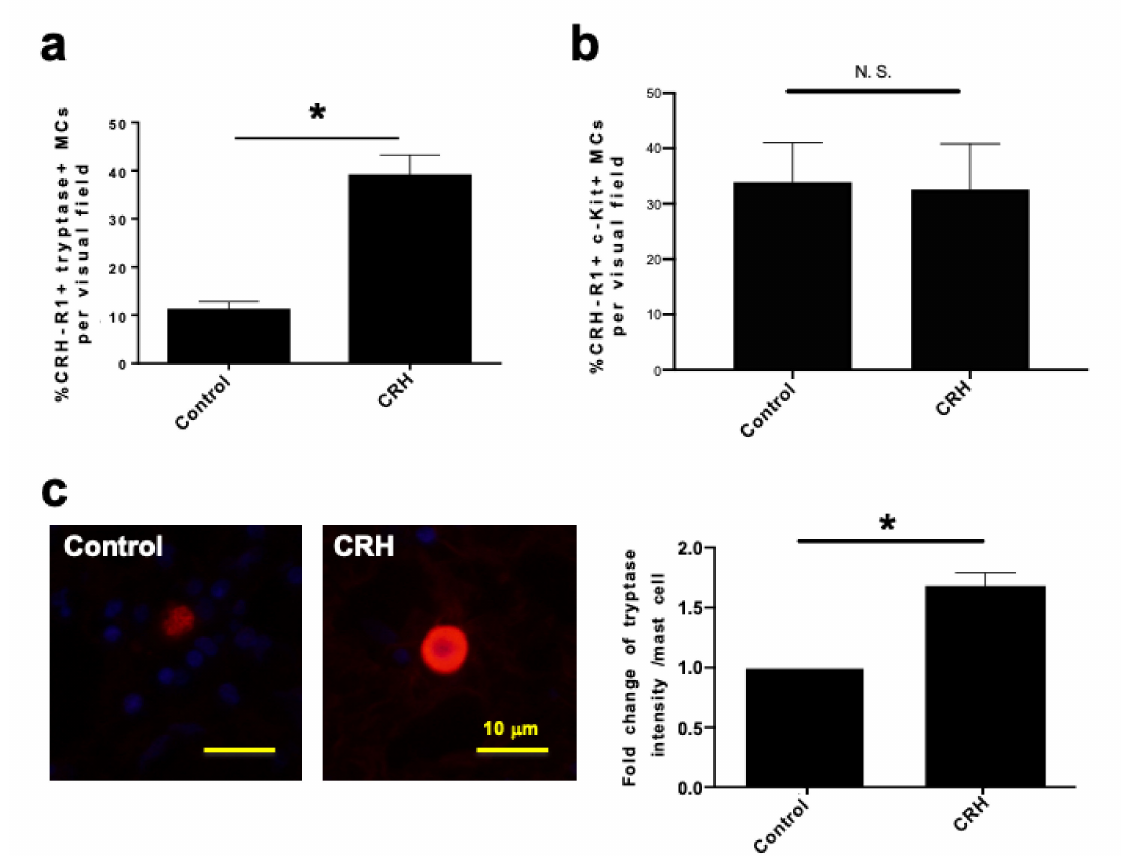
Figure 5. CRH increased the expression of CRH-R1 on tryptase+ hM-MCs and upregulated tryptase immunoreactivity within the hM-MCs. Percentage of ( a ) tryptase+ and ( b ) c-Kit+ MCs with CRH-R1 in the lamina propria of organ-cultured human NPs, analyzed by double immunofluorescence of tryptase or c-Kit/CRH-R1. n = 7 in ( a ) and 4 in ( b ). ( c ) Tryptase immunoreactivity within the hM-MCs in NPs treated with vehicle or CRH. CRH treatment significantly increased tryptase immunoreactivity within hM-MCs. n = 5; scale bar = 10 µ m. Error bars indicate SEM. * p < 0.05, N.S. = not significant. MC, mast cell; hM-MCs, human nasal mucosa MCs; NPs, nasal polyps; CRH, corticotropin-releasing hormone; CRH-R1, CRH receptor type